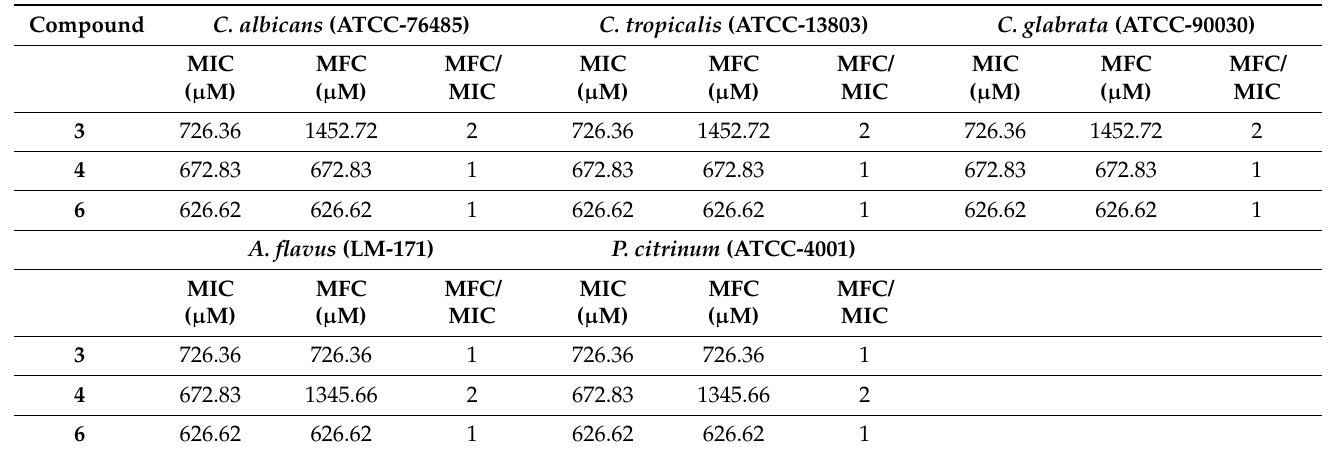
Table 2. Minimum inhibitory concentration (MIC) and minimum fungicide concentration (MFC) of compounds, 3 , 4 , and 6 .